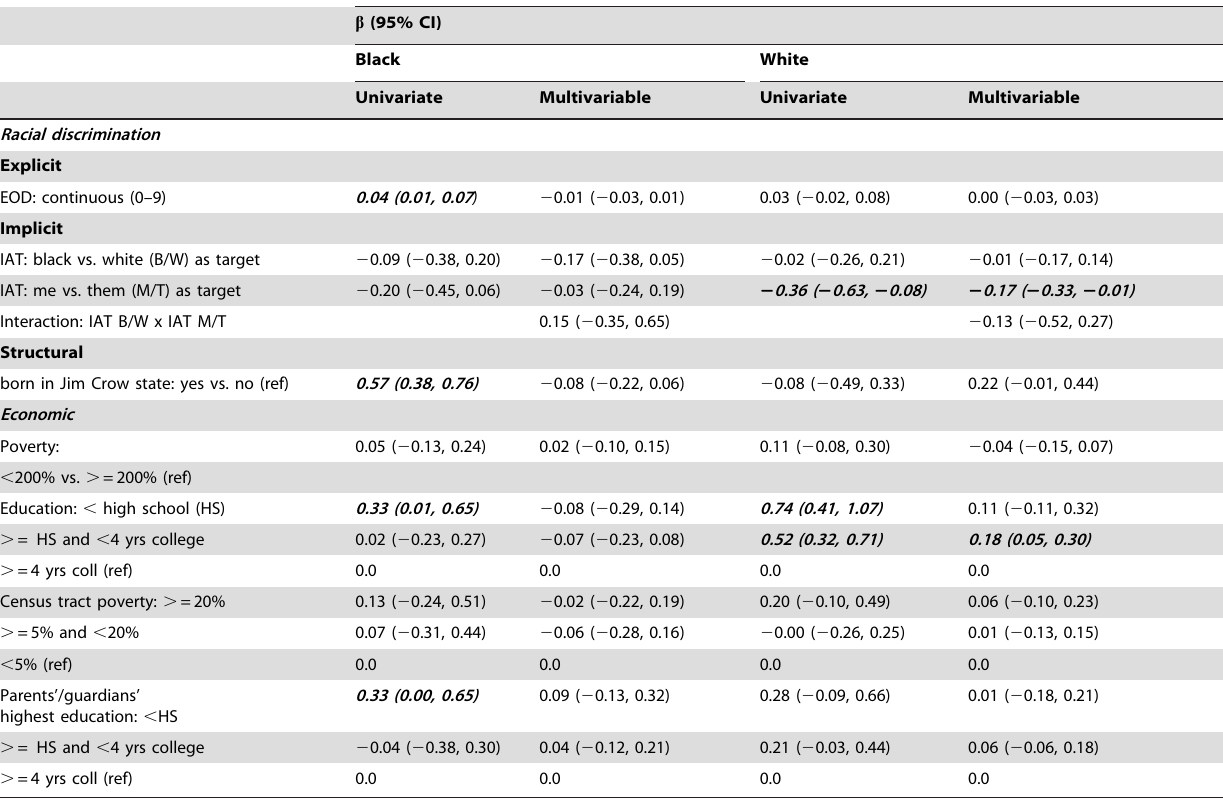
Table 5. Univariate and multivariable associations of racial discrimination and socioeconomic position with Framingham 10-year cardiovascular risk scores: My Body My Story study (504 black, 501 white US born non-Hispanic participants; Boston, 2009–2010) (imputed